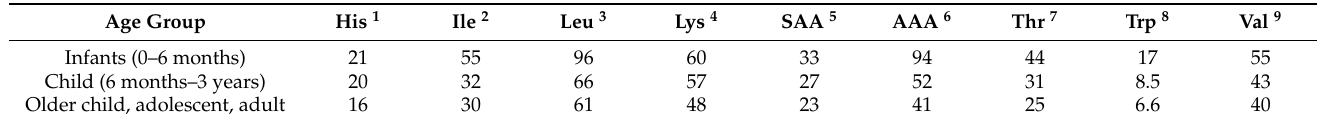
Table 2. Recommended amino acid scoring patterns for infants, children and older children, adolescents, and adults (mg/g protein requirement) [35].